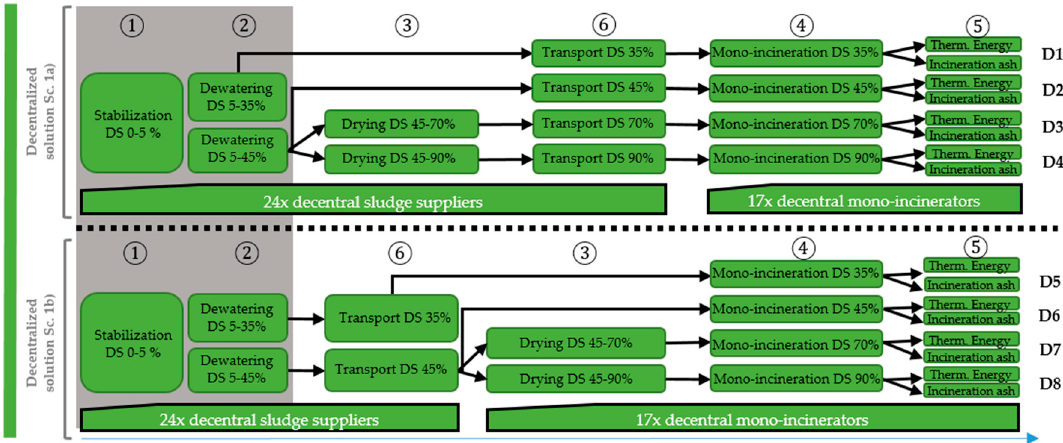
Figure 6. Decentralized and scenarios 1( a ), ( b ) including sludge pre-treatment options 1–4.